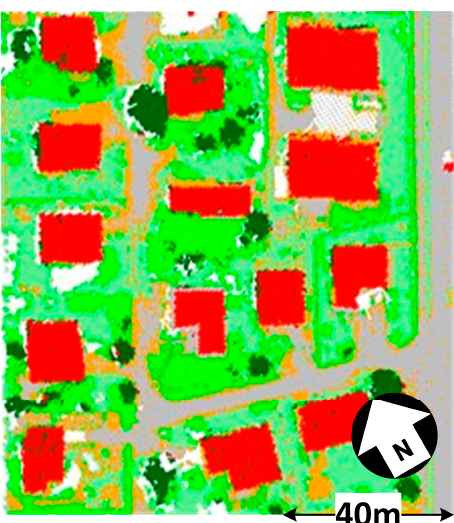
Figure 13. Generated land cover map (classification result). Six classes are coded by colors (red = “building”, light green = “grass”, dark green = “tree”, green = “hedge and bush”, grey = “road and parking lot”, orange = “wall and car port”). Taken from [12].